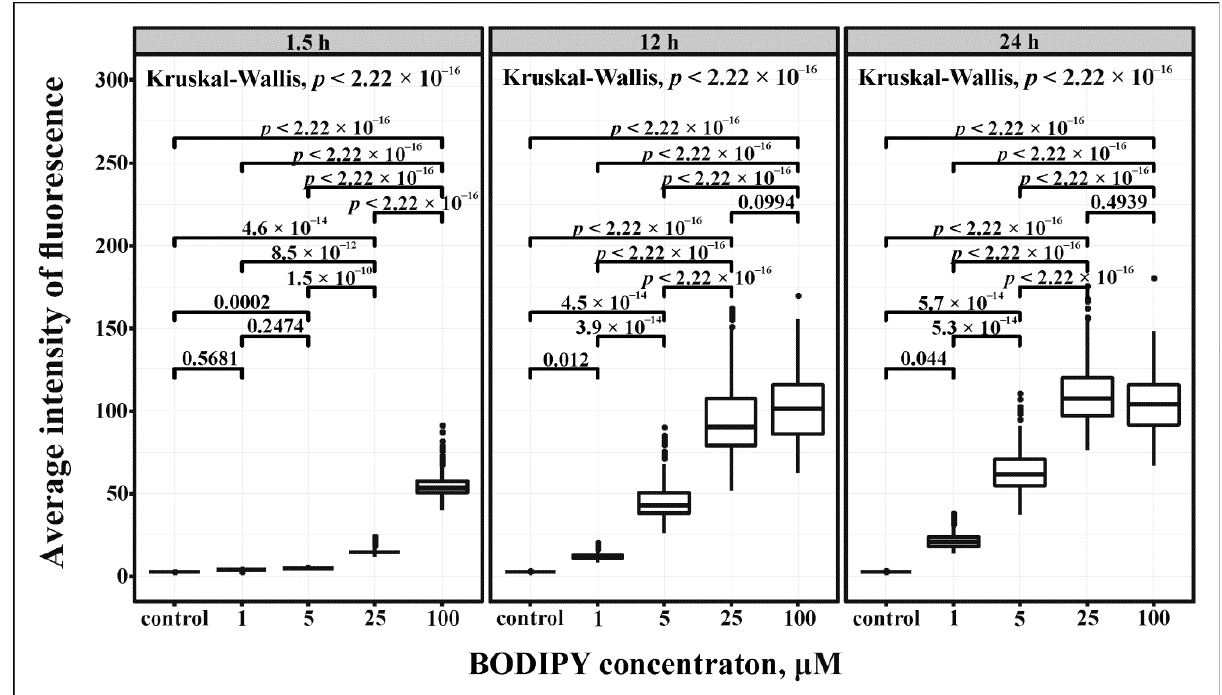
Figure 10. Comparison of the average fluorescence intensities observed in Ehrlich ascites carcinoma cells after 1.5, 12, and 24 h of incubation with BODIPY 1 at concentrations of 1, 5, 25, and 100 µ M. Medians, and first and third quartiles are presented; significant differences are considered when p -value < 0.05. The posterior comparison was carried out by concentration.